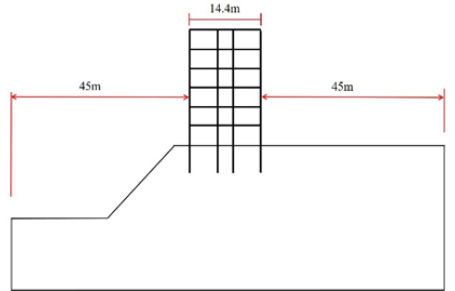
Figure 1. Schematic diagram of soil range.